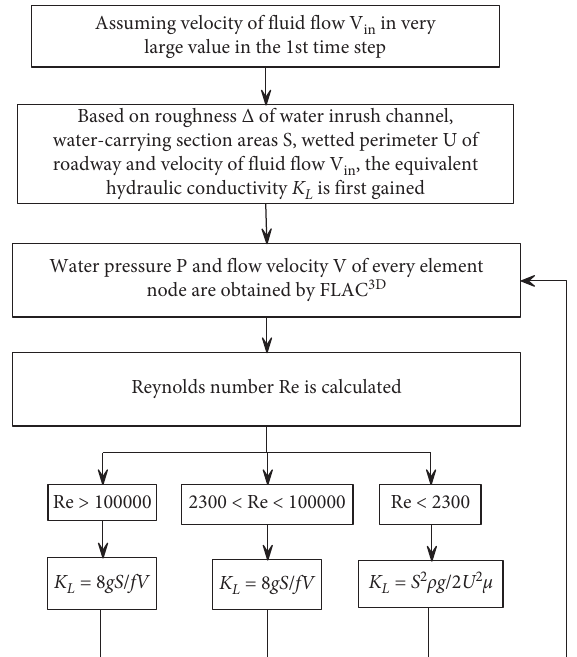
Figure 3: The equivalent hydraulic conductivity K calculation time